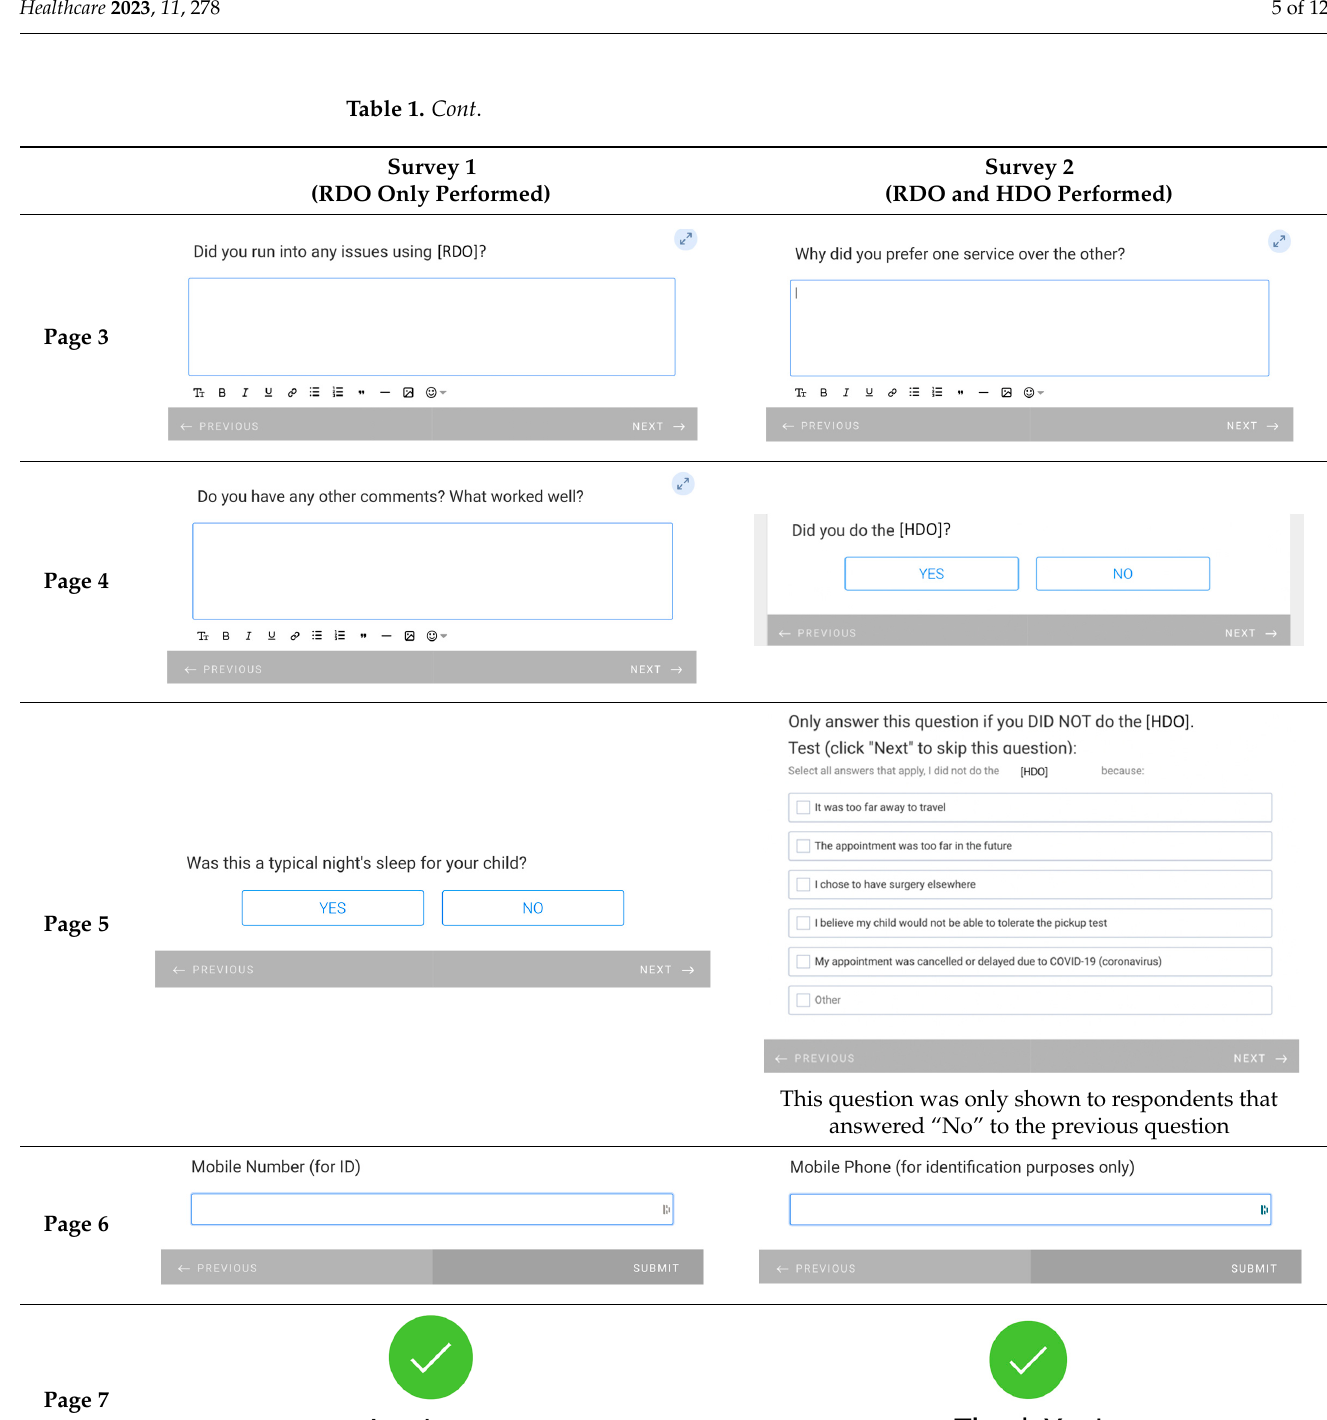
Table 1. Follow-up surveys: The follow-up surveys sent to patients during the trial are shown. Survey 1 was sent after the patient completed the RDO. Survey 2 was sent after the patient had completed both the RDO and HDO. However, as the COVID-19 pandemic progressed, appointments for the HDO were delayed or cancelled. Therefore, questions shown in “Page 4” and “Page 5” for Survey 2 were added, and Survey 2 was sent to patients regardless of completion of the HDO. Survey 1 (RDO Only Performed) Survey 2 (RDO and HDO Performed)